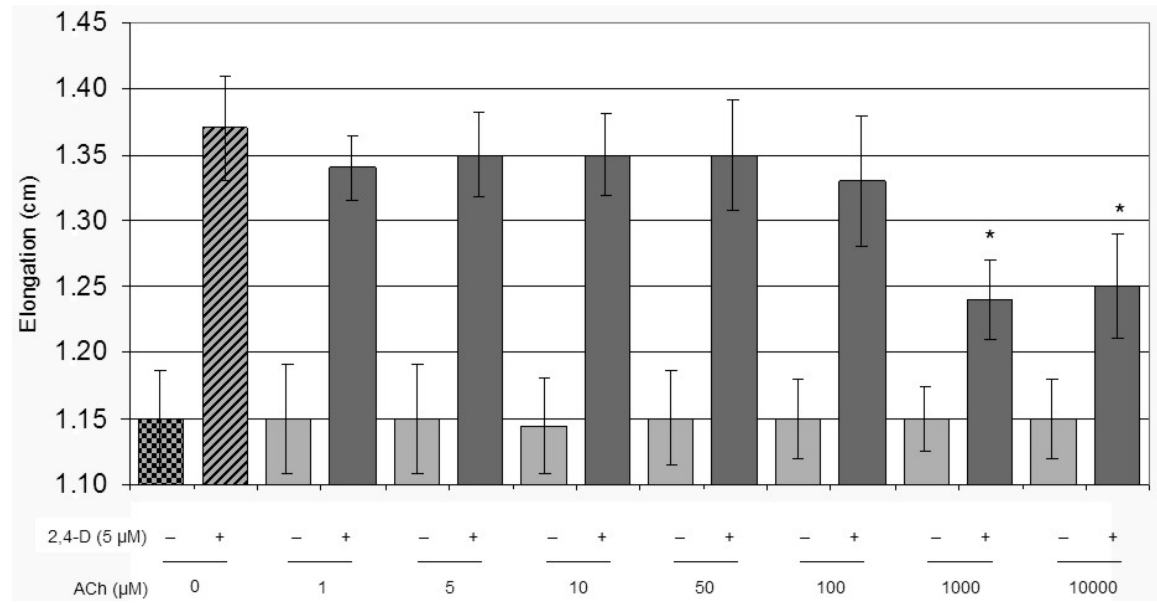
Figure 1. Effects of acetylcholine on tomato hypocotyl segments elongation. Hypocotyl segments were incubated for 16 h in buffer and increasing concentrations of acetylcholine (ACh) as indicated in the figure, with or without 5 μ M 2,4-D. Hypocotyl segment length data are mean ± SE, n = 20. Group means were analysed by ANOVA followed by Tukey test ( * p <